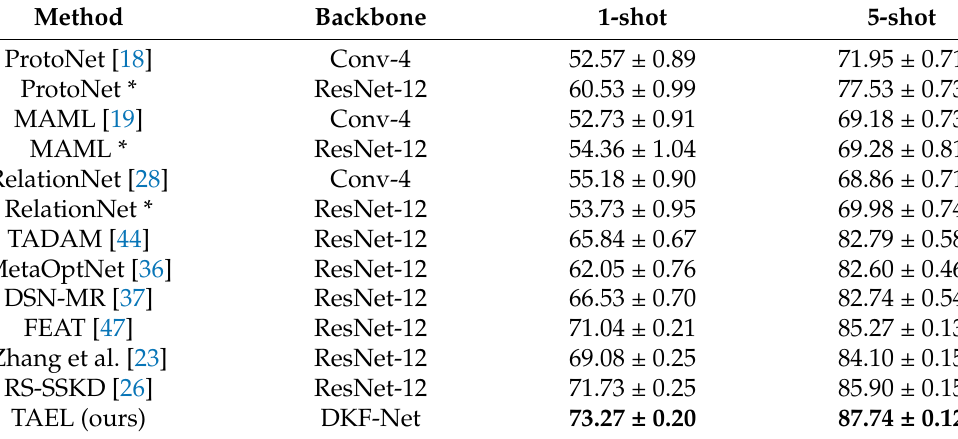
Table 5. Comparison to previous works on RSD46-WHU. Average 5-way few-shot classification accuracy (%) is reported with 95% confidence intervals. The symbol * denotes the backbone of the original model is replaced with ResNet-12, and the results are reported in [23]. The best results in each column are marked in